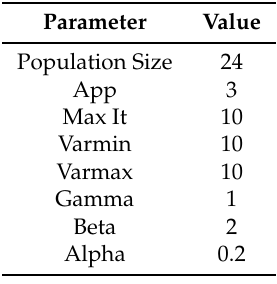
Table 4. FA parameters and values.